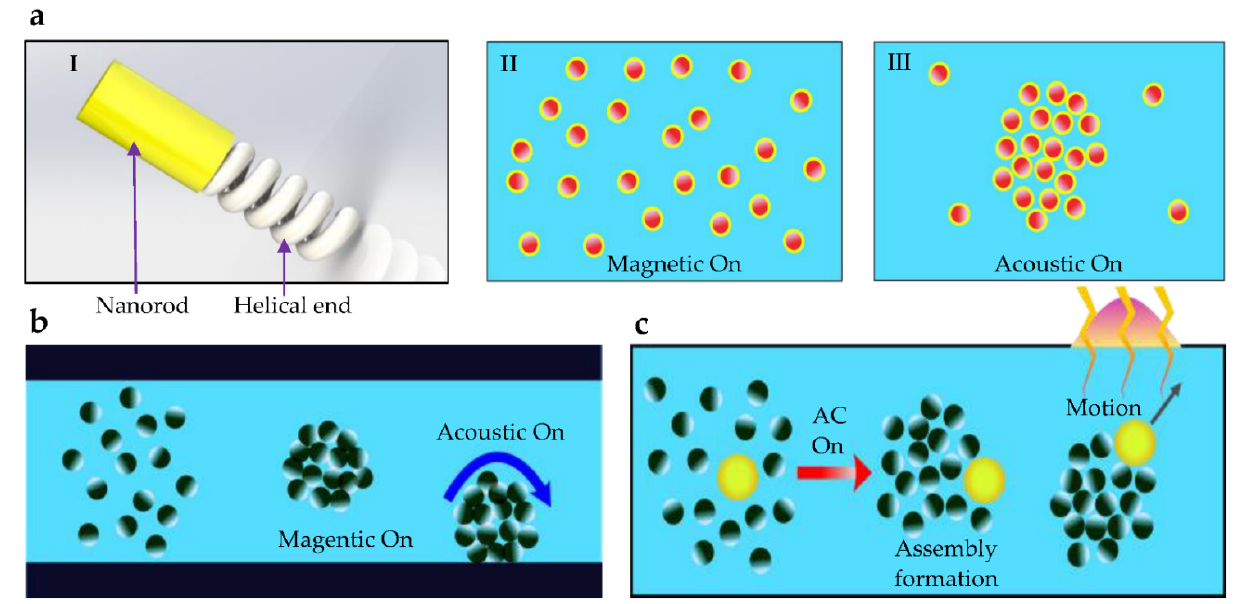
Figure 5. Shape formation techniques using hybrid methods: ( a ) Schematic illustration of the design of magneto-acoustic nanomotors and reversible assembly formation [84]. Under a magnetic field, swarm motion is achieved, whereas the application of the acoustic signal forces the nanomotors to aggregate. ( b ) Supermagnetic particles aggregate as a result of an external magnetic field. When the acoustic field is applied, the collective rotates along the surface [85]. ( c ) Under electric actuation, TiO 2 particles assemble into a formation, and the UV field allows precise motion control of the swarm along the required trajectory [50].